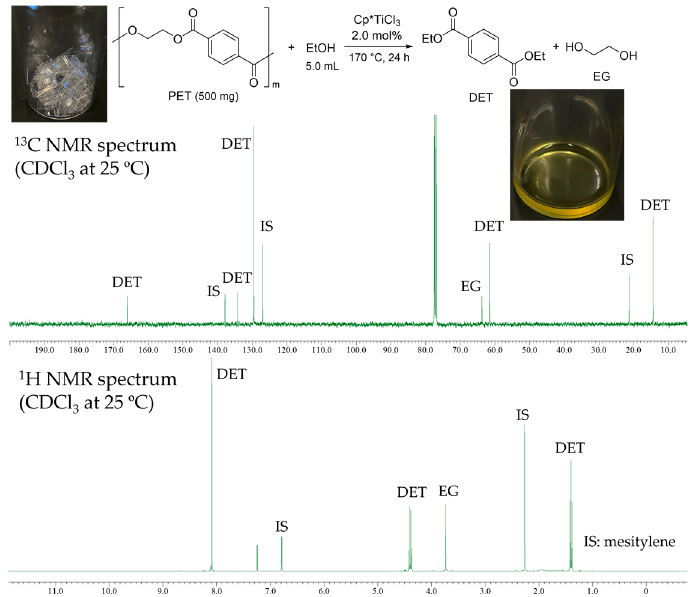
Figure 6. NMR spectra (in CDCl 3 at 25 °C) for transesterification of PET with ethanol by Cp*TiCl 3 (2.0 mol%). Conditions: PET sheets (from the bottle) 500 mg, ethanol 5.0 mL, 170 °C, 24 h (run 21).